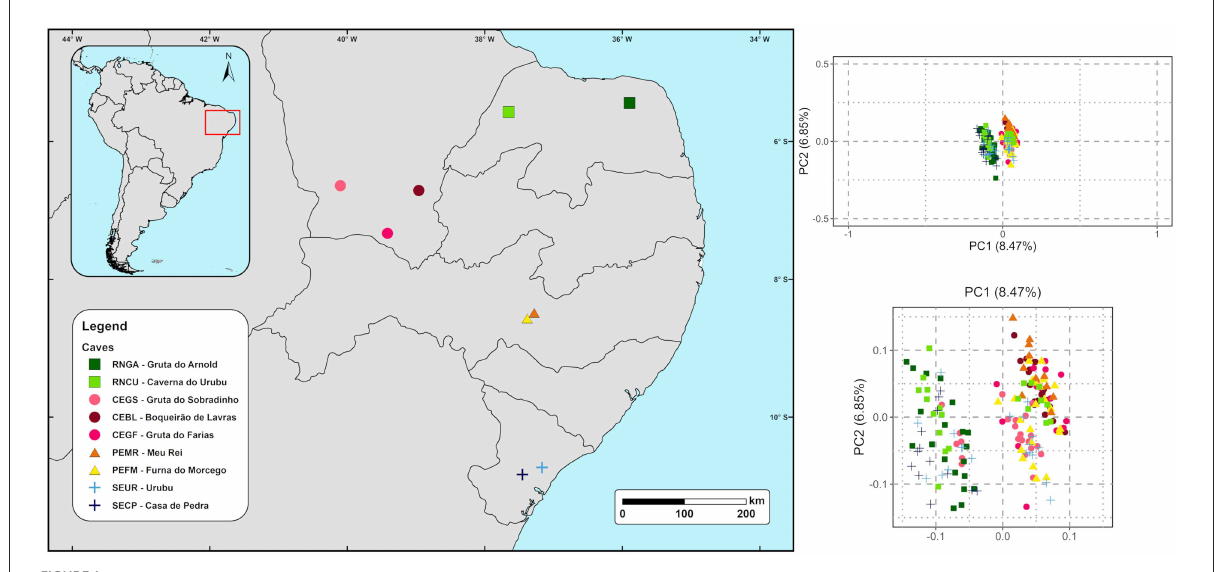
FIGURE1 Bat caves in northeastern Brazil where Pteronotus gymnonotus bats were sampled (Left) and the genetic structure of the species shown by a principal component analysis (PCA) (Right) . The two most important components explain 15.32% of the nucleotide variation for the species.